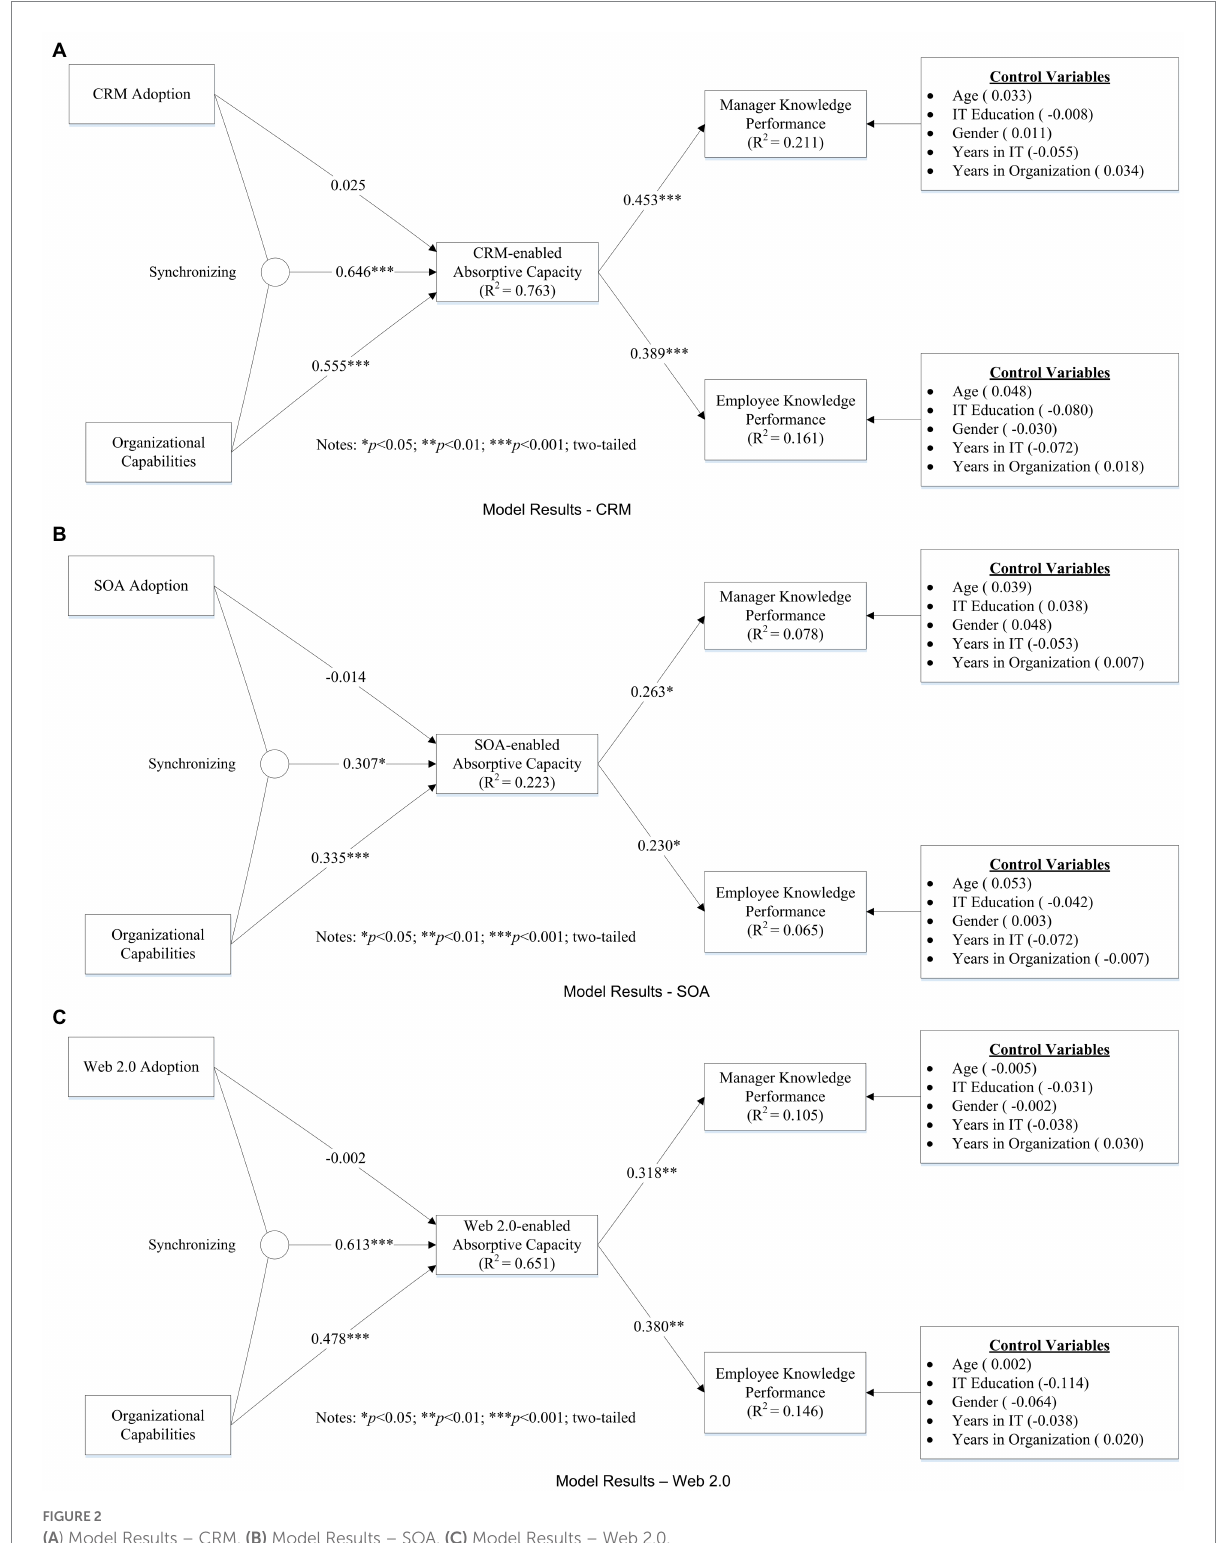
FIGURE 2 (A ) Model Results – CRM. (B) Model Results – SOA. (C) Model Results – Web